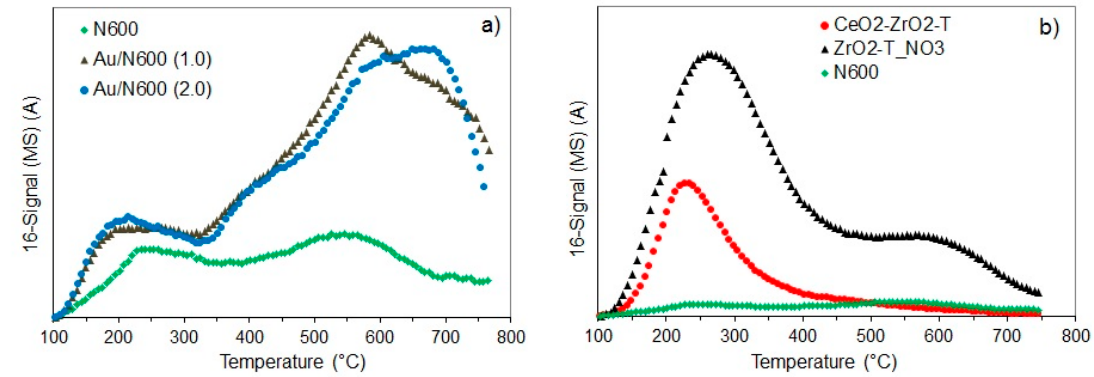
Figure 3. NH 3 - Temperature Programmed Desorption (TPD) profiles of ceria and Au deposited on ceria ( a ) and of the supports ( b ).